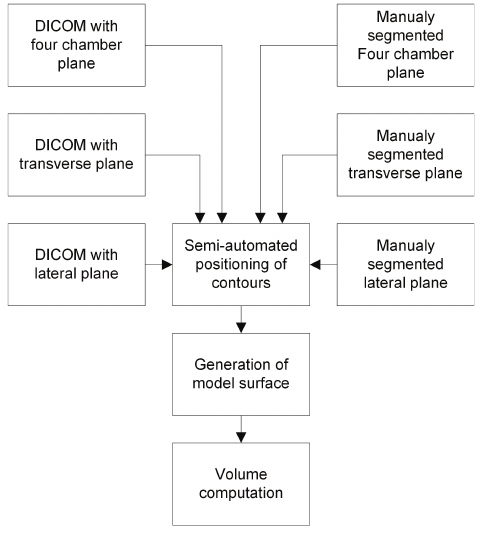
Figure 2. Diagram for ventricle volume